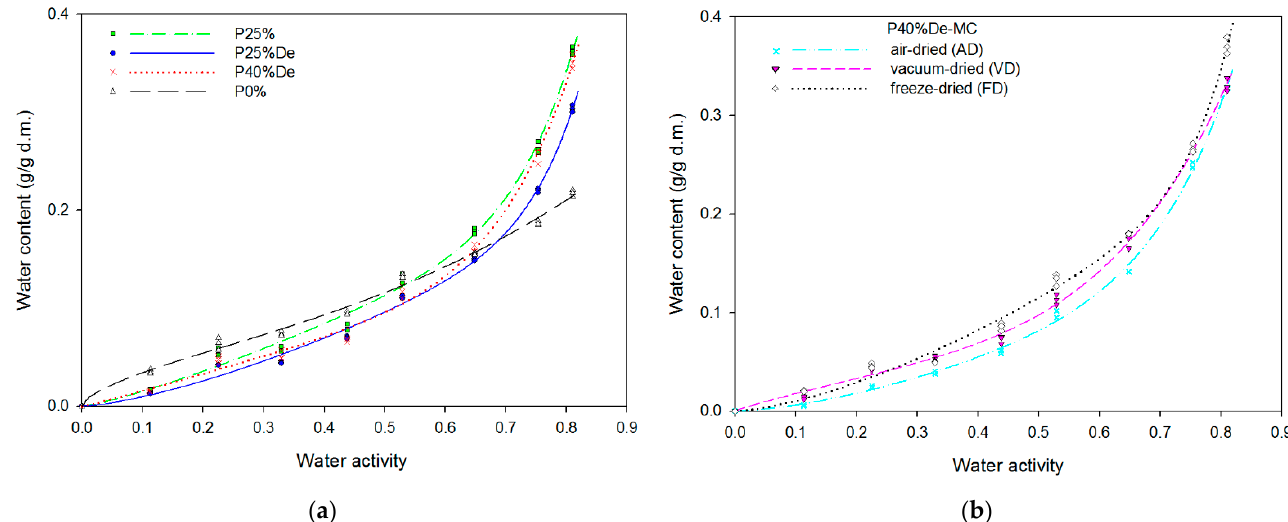
Figure 1. Water sorption isotherms of dried gels: ( a ) freeze-dried (non-foamed) gels with different compositions; ( b ) P40%DE-MC gels dried by AD, VD and FD techniques.